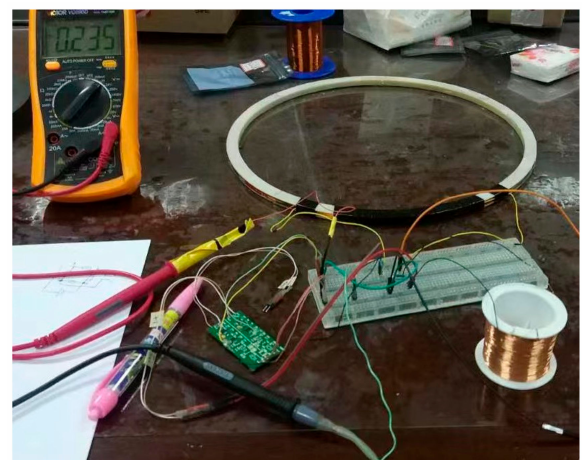
Figure 7. Eddy current coil